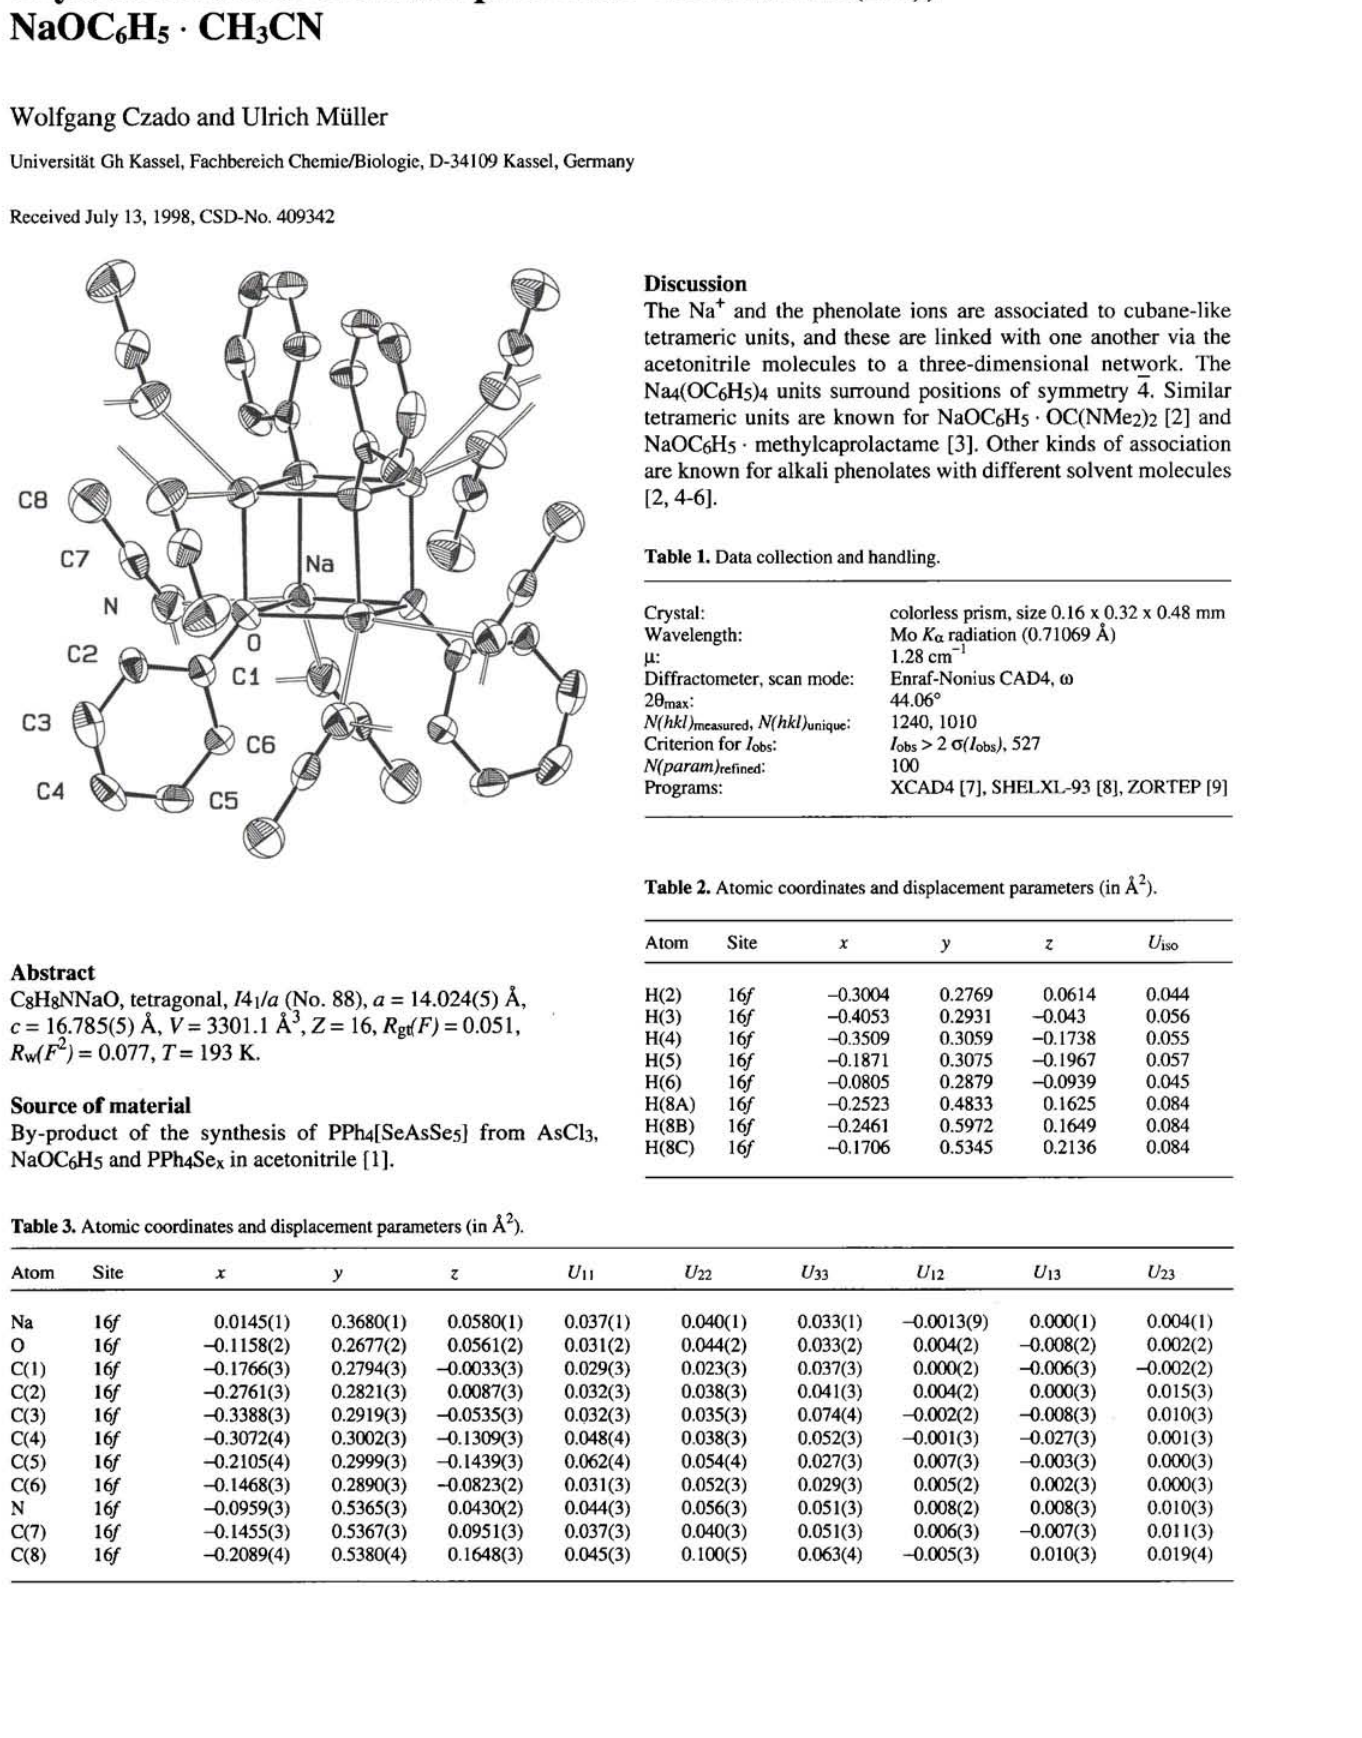
Table 1. Data collection and handling. Crystal: